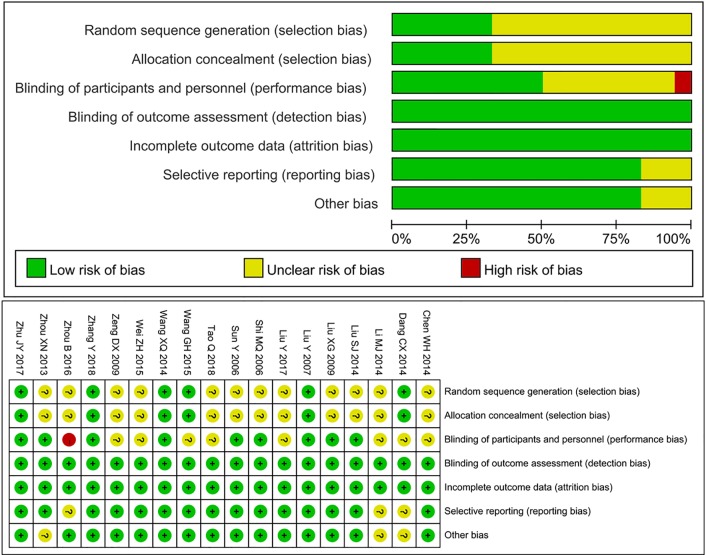
Risk of bias graph.